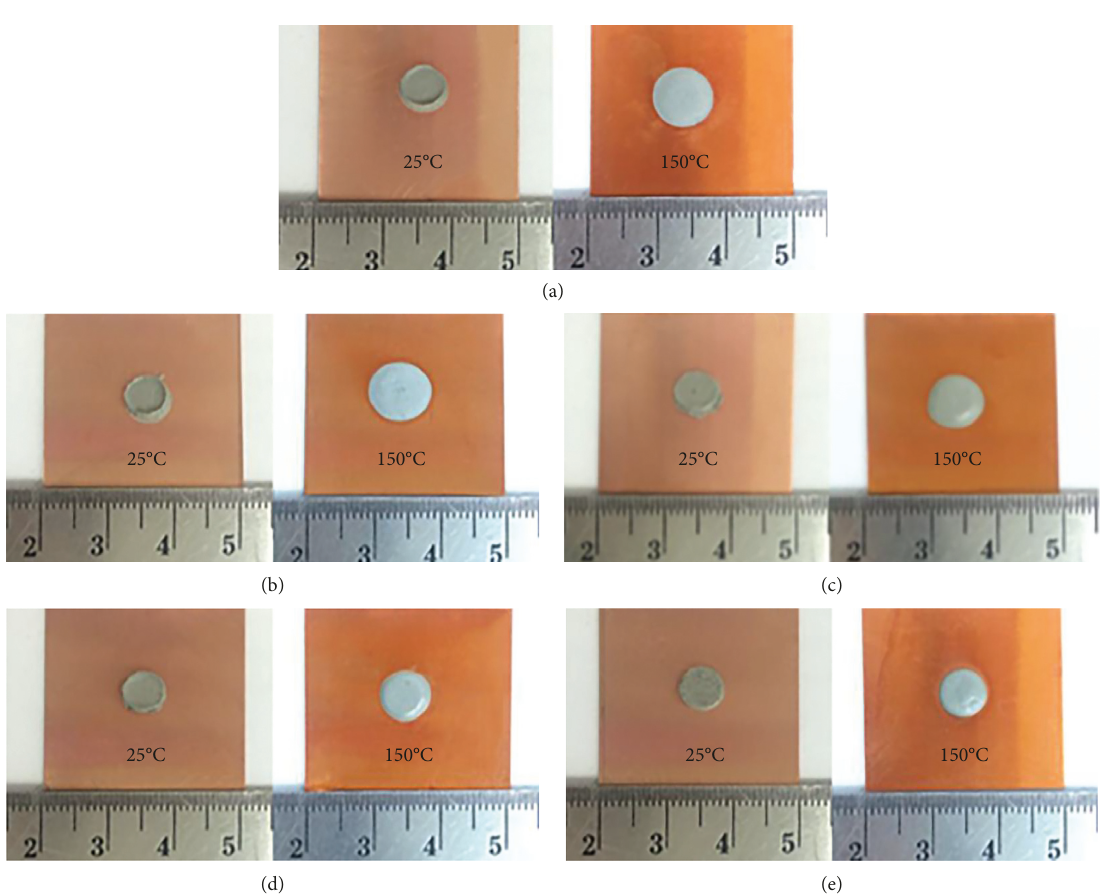
Figure 5: The slumping of the SAC0307-xZnO solders on the copper substrate: (a) SAC0307, (b) SAC0307-0.25ZnO, (c) SAC0307- 0.50ZnO, (d) SAC0307-0.75ZnO, and (e) SAC0307-1.0ZnO.